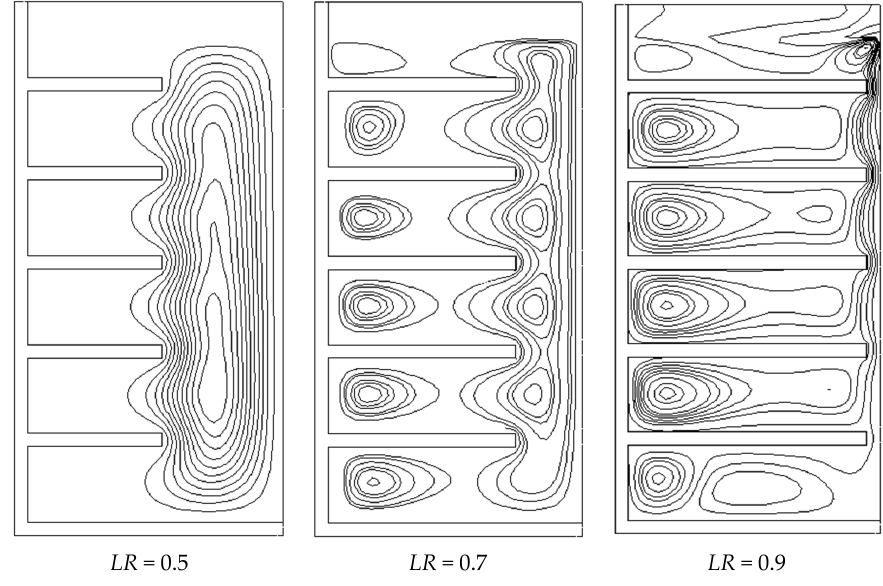
Figure 8. Convection strength at LR = 0.5, 0.7 and 0.9 ( n = 5, H = 10 mm).